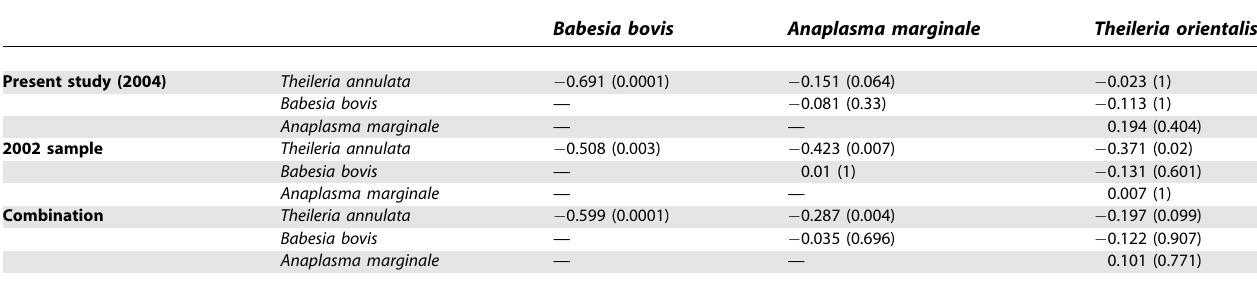
Table 1. Within-Cattle Occurrence Correlation between